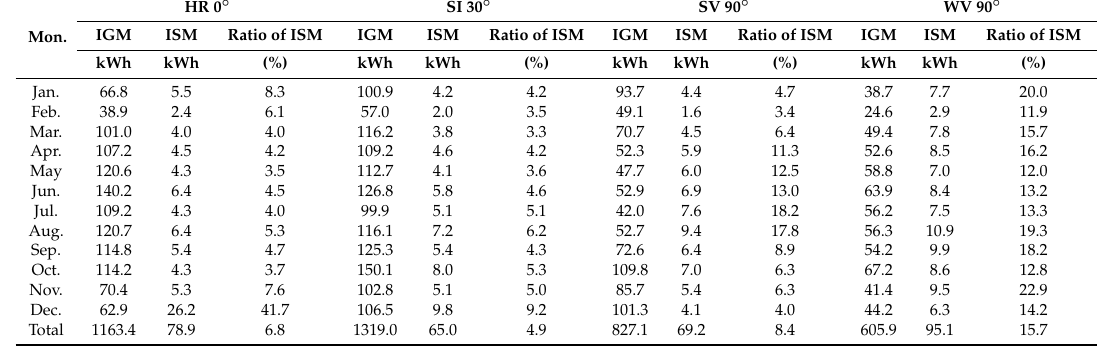
Table 8. Analysis results of irradiation during generation mode (IGM) and irradiation during standby mode (ISM).